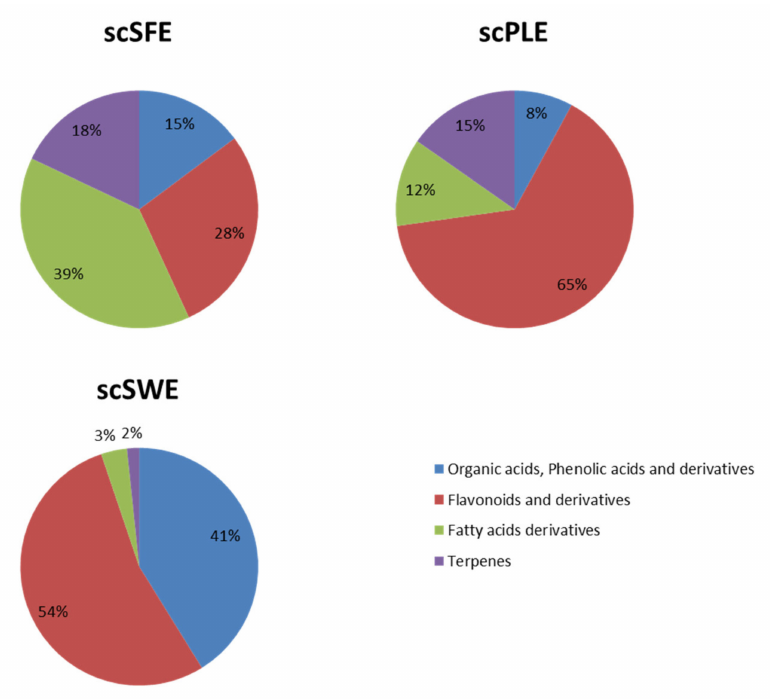
Figure 2. Semiquantitative data regarding the di ff erent families of compounds extracted by SFE (scSFE), PLE (scPLE), and SWE